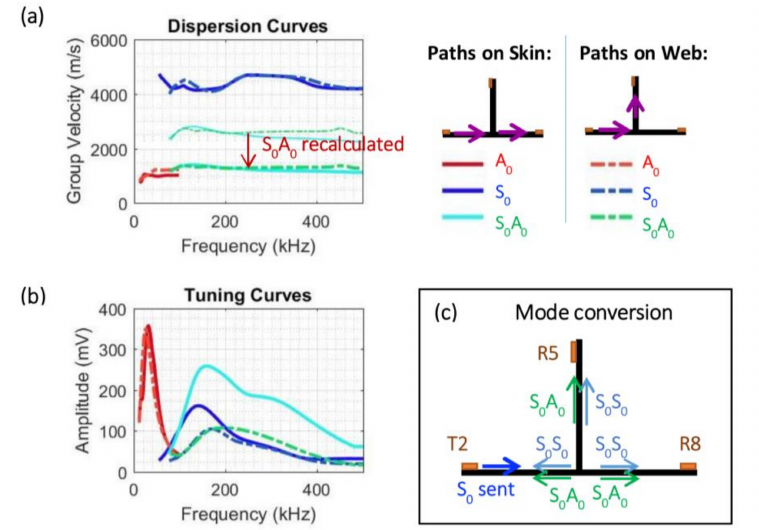
Figure 7. Experimental ( a ) dispersion and ( b ) tuning curves for paths on skin and web; ( c ) Mode conversions at structural discontinuity of a T-joint for S 0 mode transmitted from PZT ‘T2’ and received by PZTs ‘R8’ on skin and ‘R5’ on